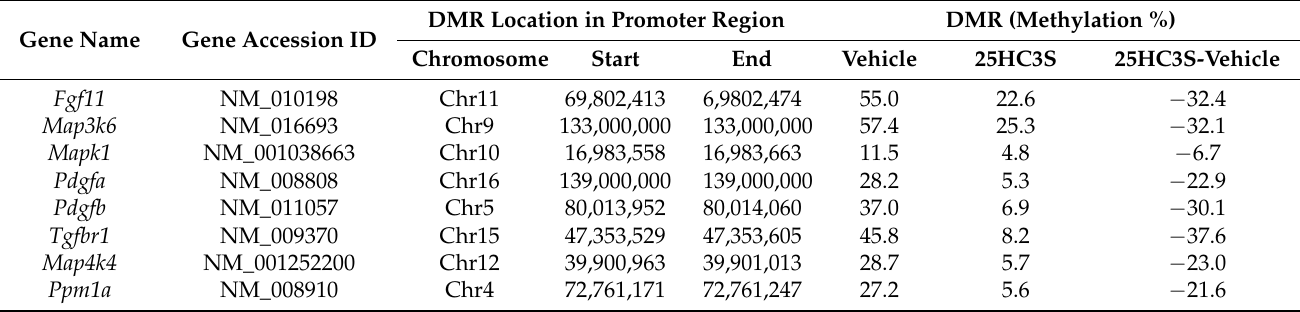
Table 2. Methylation of DMR in gene promoter regions of MAPK signaling